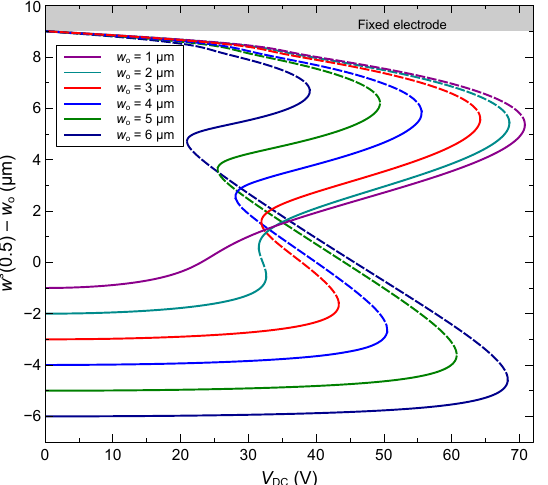
Figure 8. Static response at the midpoint of the arch microbeam for different initial rises (half- electrode